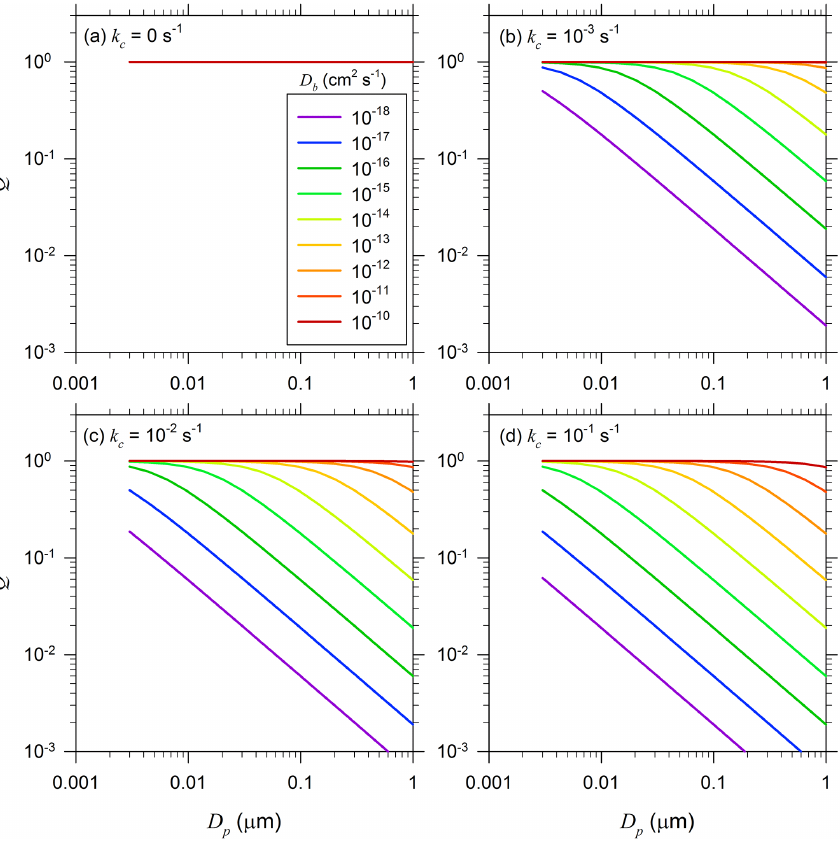
Figure 7. Dependence of Q on particle diameter D p for D b values ranging from 10 − 10 to 10 − 18 cm 2 s − 1 : (a) k c = 0 s − 1 , (b) k c = 10 − 3 s − 1 , (c) k c = 10 − 2 s − 1 , and (d) k c = 10 − 1 s − 1